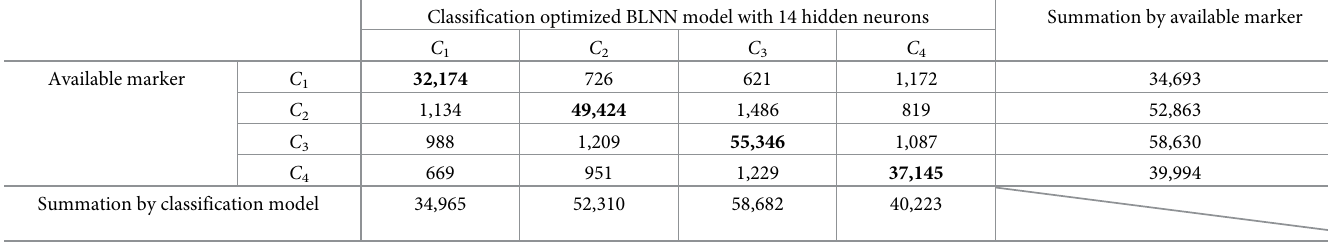
Table 4. The discriminant confusion matrix conducted based on the adaptively optimized BLNN model built up with 14 hidden neural nodes. Classification optimized BLNN model with 14 hidden neurons Summation by available marker